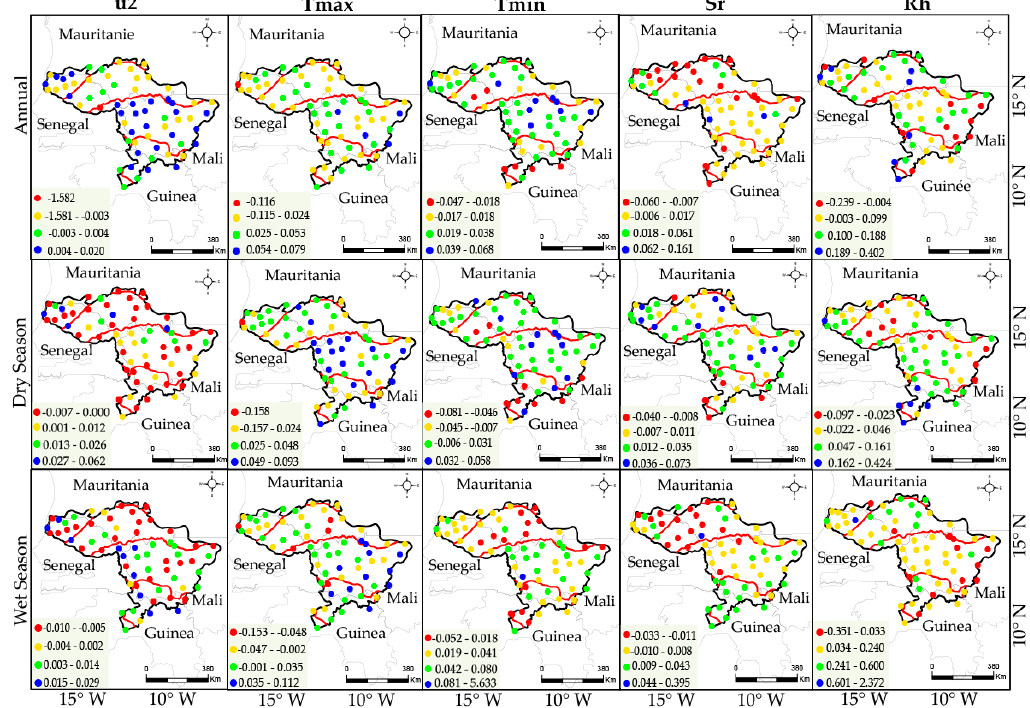
Figure 8. Spatial distribution of the Sen slope of climatic variables on an annual scale: u2 wind speed, Tmax maximum temperature, Tmin minimum temperature, Sr, Solar radiation, Rh relative humidity.